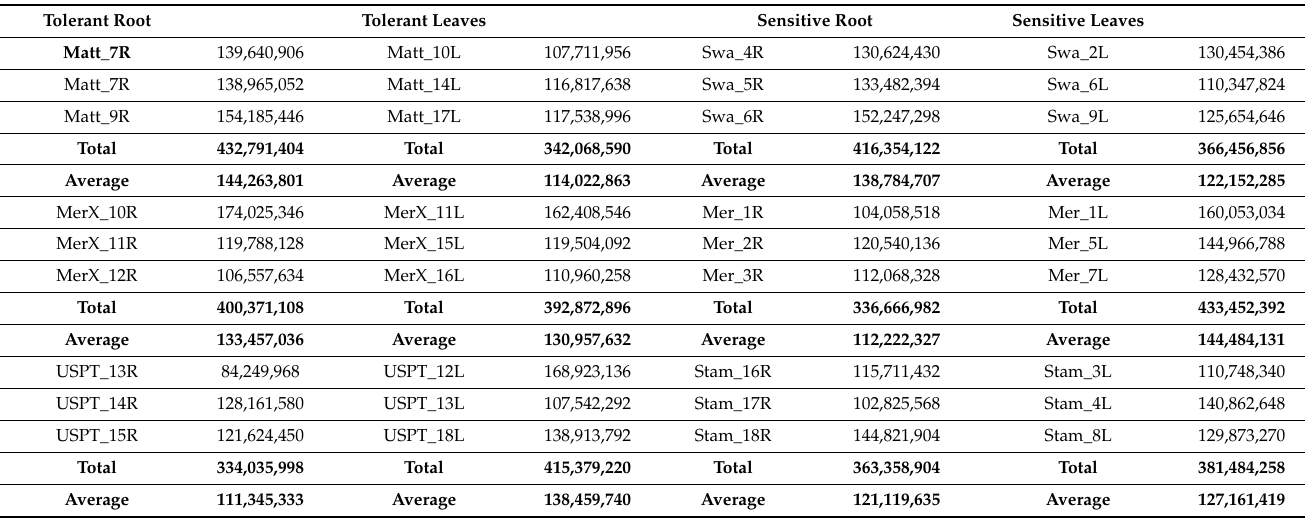
Table 1. Summary of reads with average read counts for the individual samples and the cumulative totals of both roots and